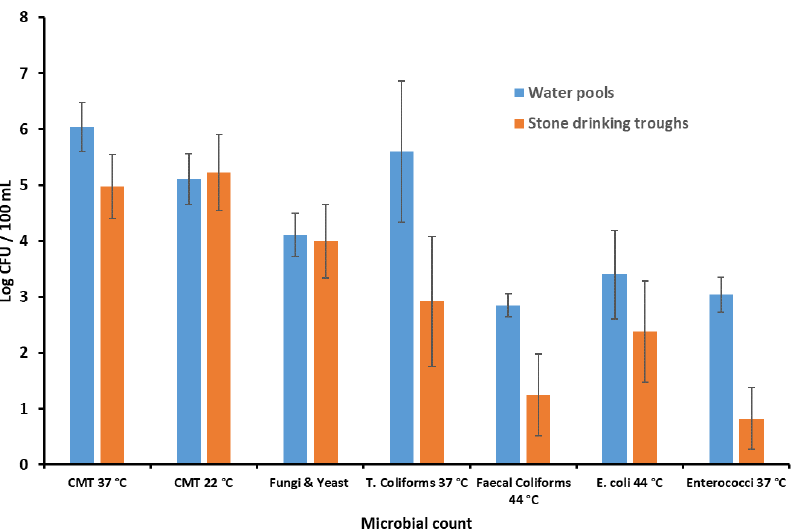
Figure 5. Comparison between a total of eight samples from water pools and stone drinking troughs, separately analyzed, in triplicate. Results are expressed as the mean ± SD. separately analyzed, in triplicate. Results are expressed as the mean ±